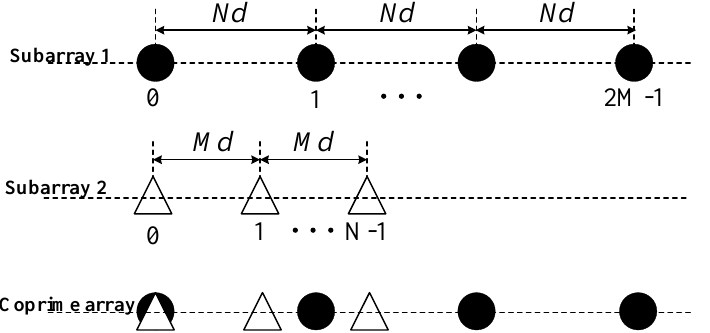
Figure 4. Extended coprime array construction.